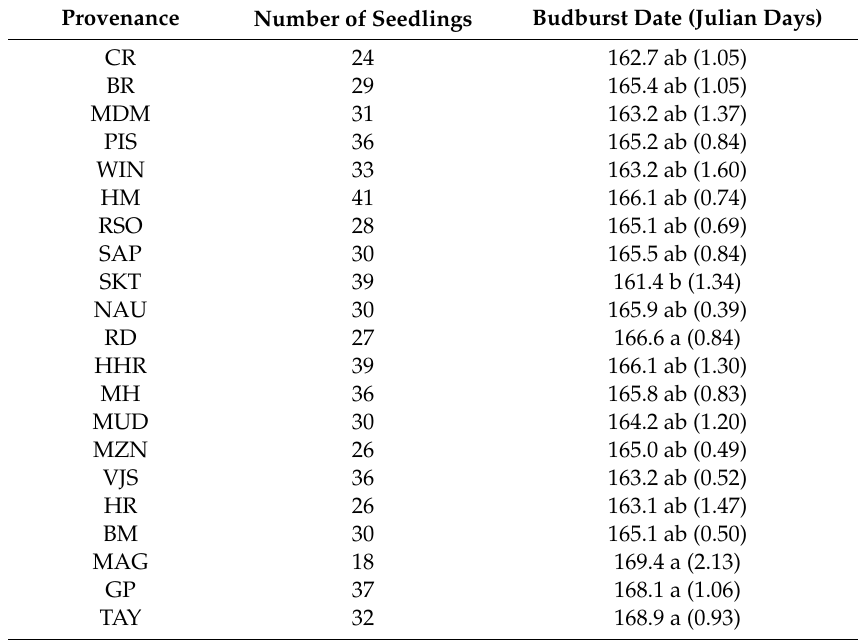
Table 3. Mean budburst for each provenance, with standard errors in parentheses (ordered by increasing elevation). Means followed by the same letter do not di ff er significantly ( p ≤ 0.05; Tukey’s